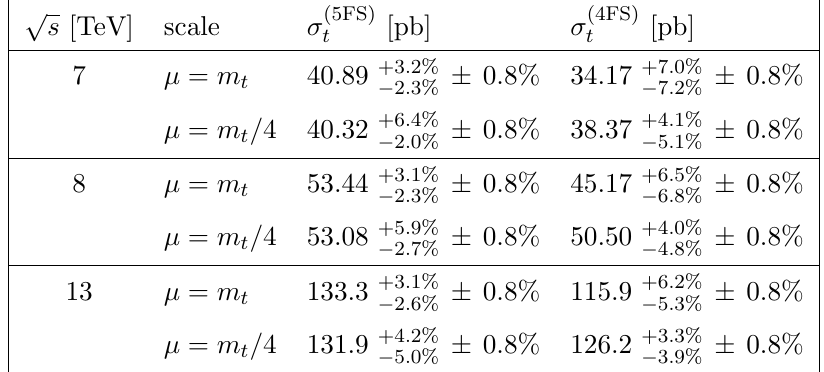
(cid:22) = m and for a lower scale (cid:22) t